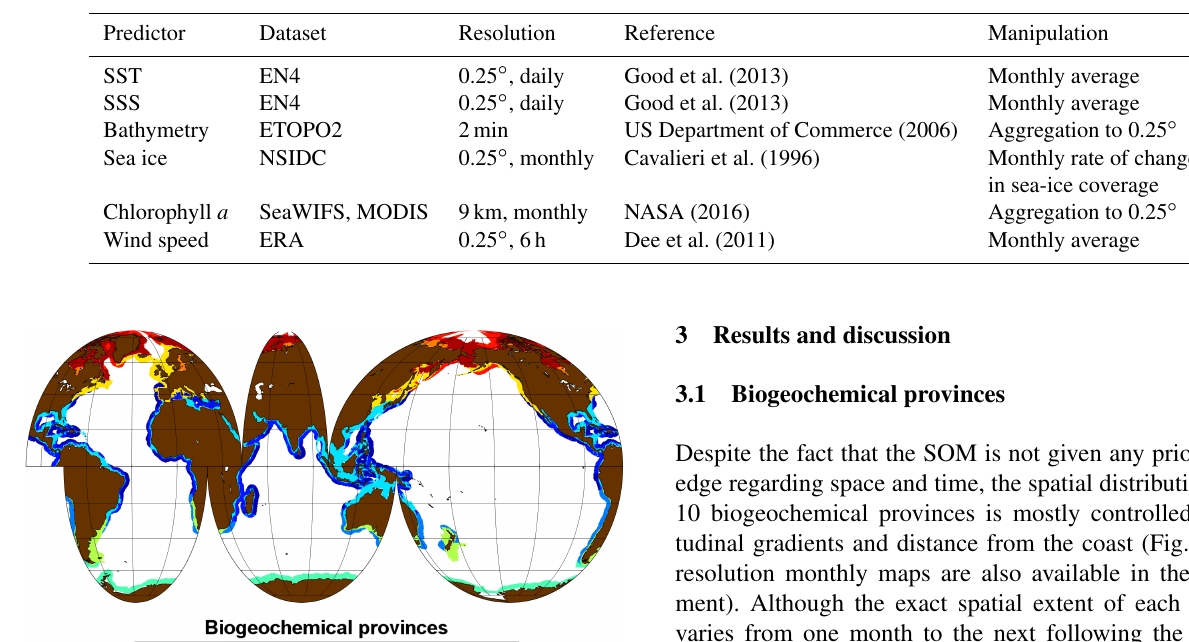
Table 1. Datasets used to create the environmental forcing files. The original spatial and temporal resolution and the main manipulations applied for their use in the SOM-FFN are also reported.